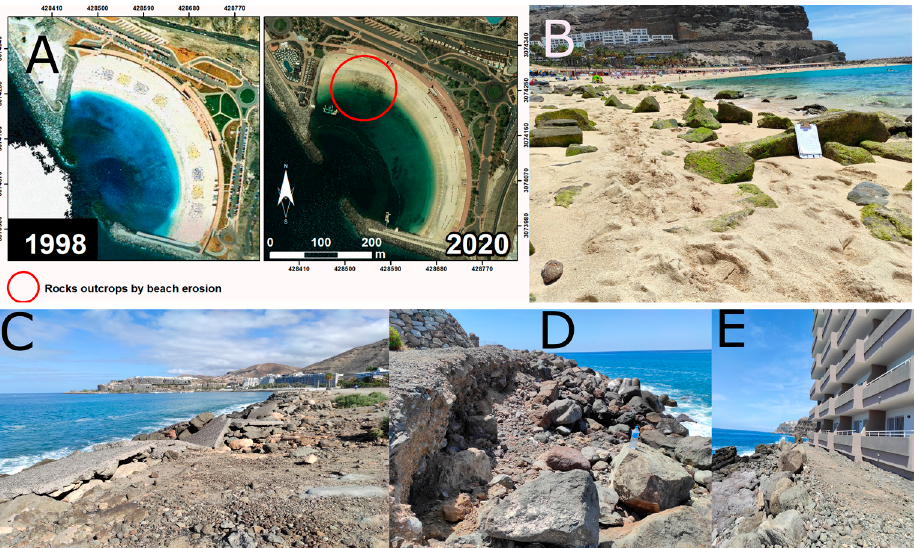
Figure 6. Environmental effects by sea storm events. ( A , B ): Rock outcrops as the result of beach erosion in Amadores between 1998 (flight carried out between October and December 1998) and 2020 (flight carried out between May 2020 and February 2021) (located in Figure 7; legend 4. Beach erosion). Fieldwork photograph (top right) taken on 19 April 2021. Orthophoto source: SDI Canarias (Canary Islands, GRAFCAN, S.A.). ( C ): seafront damage (located in Figure 7; legend 1. Seafront damage only). ( D ): breakwater damage (located in Figure 7; legend 2. Breakwater damage only). ( E ): affected seafront and breakwater located within 4 m of a tourist building (located in Figure 7; legend 3. Seafront and breakwater damage).